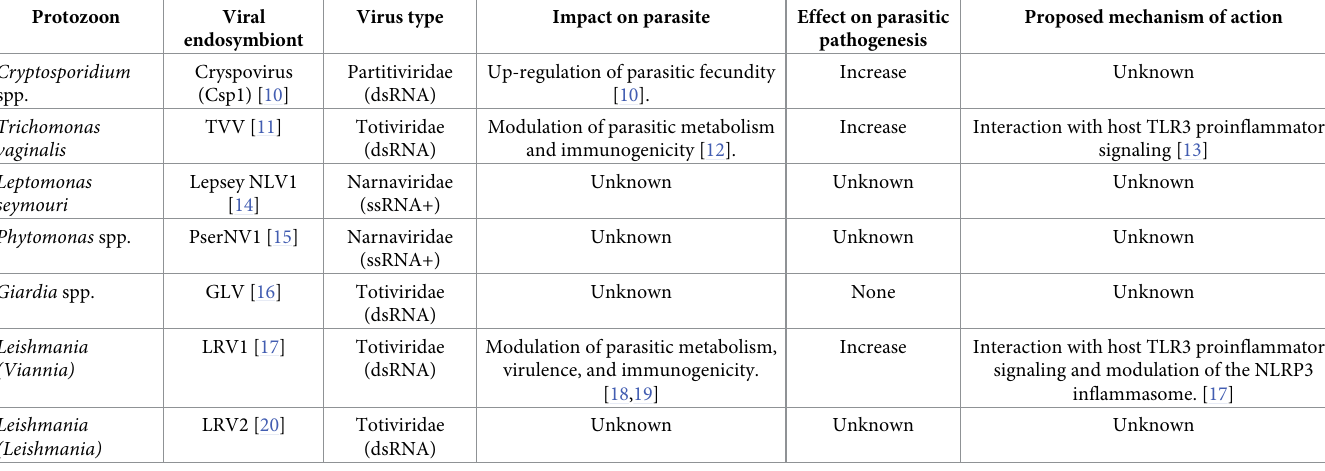
Table 1. Viral endosymbionts of protozoa can affect parasitic pathogenesis AU : AbbreviationlistshavebeencompiledforthoseusedinTable 1 andFig 1 : Pleaseverifythatallentriesarecorrect : .